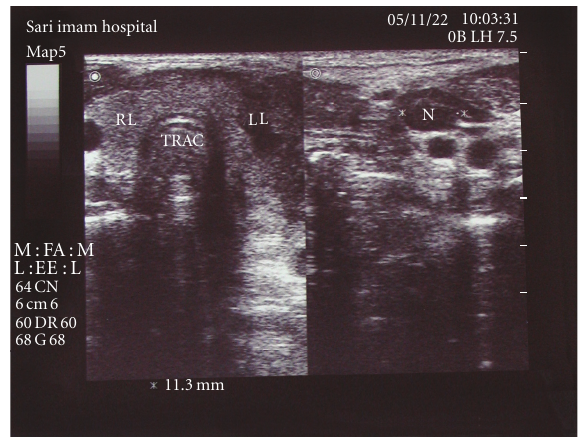
Figure 1: First sonography in the second case.